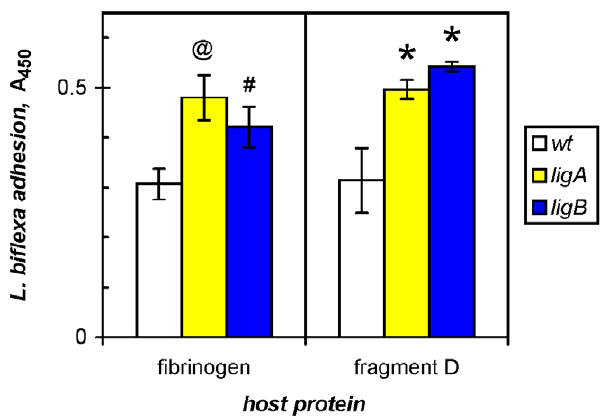
Figure 3. lig transformation of Leptospira saprophyte enhances adhesion to fibrinogen. Wild-type ( wt ) L. biflexa and cells transformed with ligA or ligB from L. interrogans were tested for binding to immobilized human fibrinogen or its fragment D in an ELISA. Three x 10 8 leptospires were incubated for 1 h at 30 u C and adherent cells fixed with formaldehyde and detected with a rabbit antibody to intact L. biflexa . A representative of multiple experiments is shown with means and standard deviations of triplicates. Statistically significant increases compared to binding by wt with each host protein were determined by one-way ANOVA (@, *, P , 0.01; # , P , 0.05).